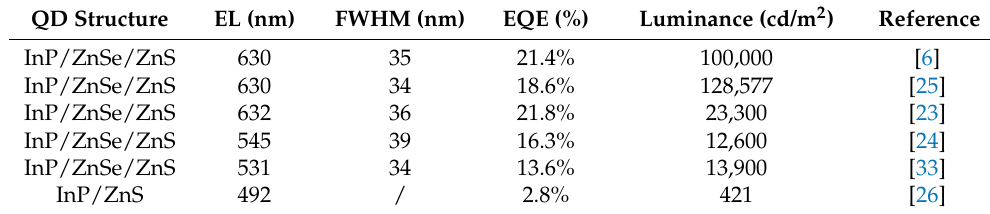
Table 1. Electroluminescent (EL) performance of RGB InP